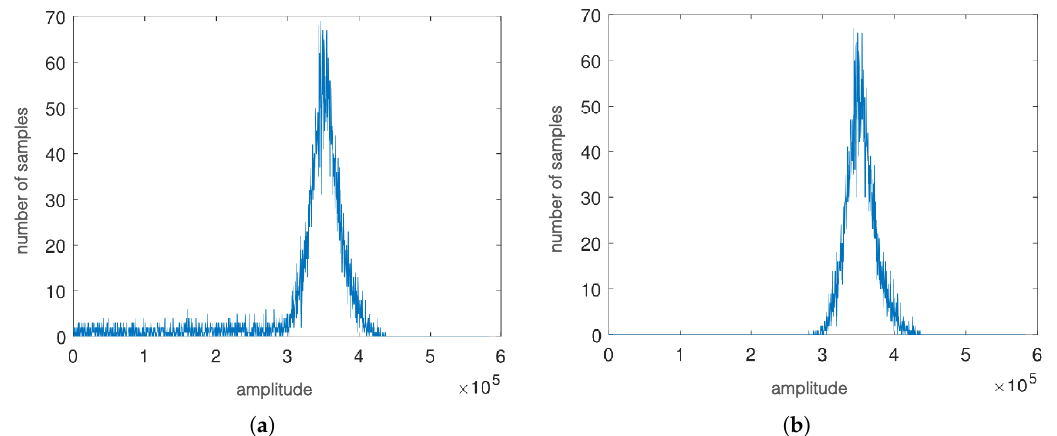
Figure 7. Distribution of the samples after accumulation, w [ n ] ; ( a ) in presence of transition samples; ( b ) in absence of transition